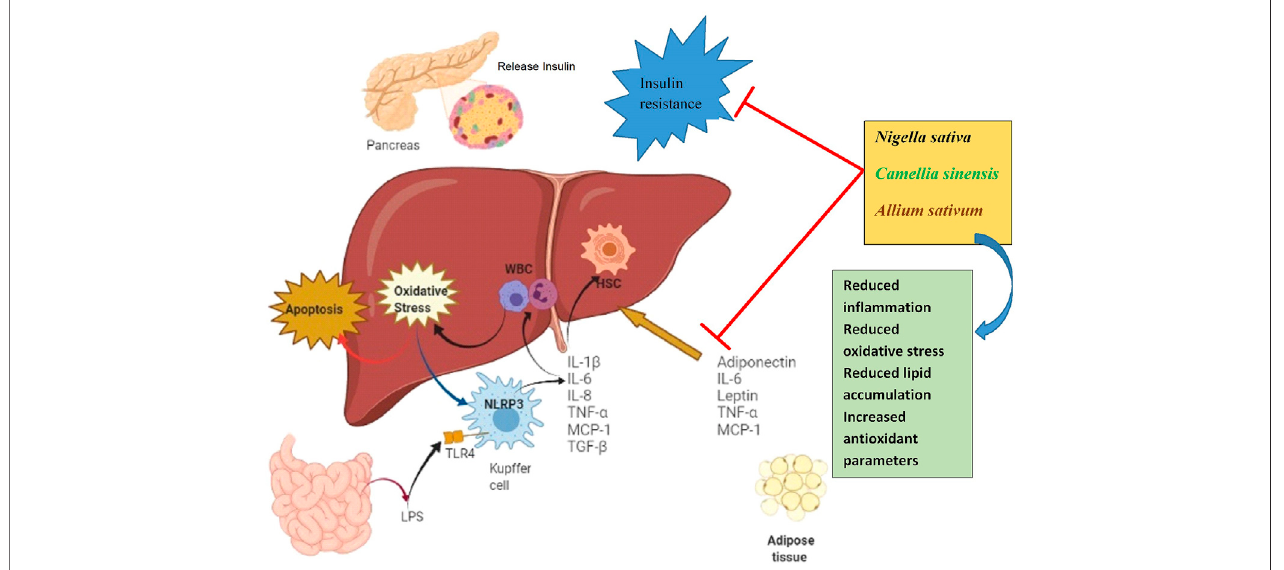
FIGURE 2 | The potential therapeutic effects of three medicinal herbs on metabolic